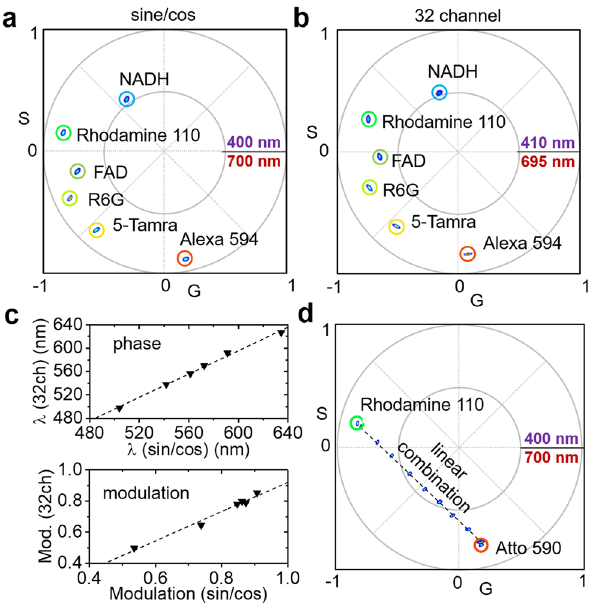
Fig. 2 Validation of phasor-based hyperspectral snapshot microscopy. a Spectral phasor plot of six different dye solutions measured with sine/ cosine fi lters (NADH, FAD, Rhodamine 110, Rhodamine 6G, 5-TAMRA, and Alexa 594). b Spectral phasor plot of the same six dye solutions measured with a commercial 32 channel hyperspectral detector. c Phases ( λ ) and modulations obtained by the sine/cosine method graphed against the values measured by conventional 32 channel hyperspectral detection with computational phasor transformation; perfect agreement was observed. d Spectral phasor plot of two dyes (Rhodamine 110 and Atto 590) mixed at different proportions. All fractions were found along a connecting line between the pure species as expected by the law of linear color maps (cyan/magenta, green/yellow). This color code was applied to the respective 4D maximum intensity projection (MIP) (Fig. 3c); a 360° rotation of a color coded 4D MIP is shown in Supplementary Movie M1. Individual colors of zoomed-in 3D MIPs (white box in Fig. 3c) are shown in Fig. 3d – g, the 4D composite MIP is shown in Fig. 3h. The intensity pro fi les for each color (Fig. 3i) matched the expected cellular composition (Fig. 3j) 22 .